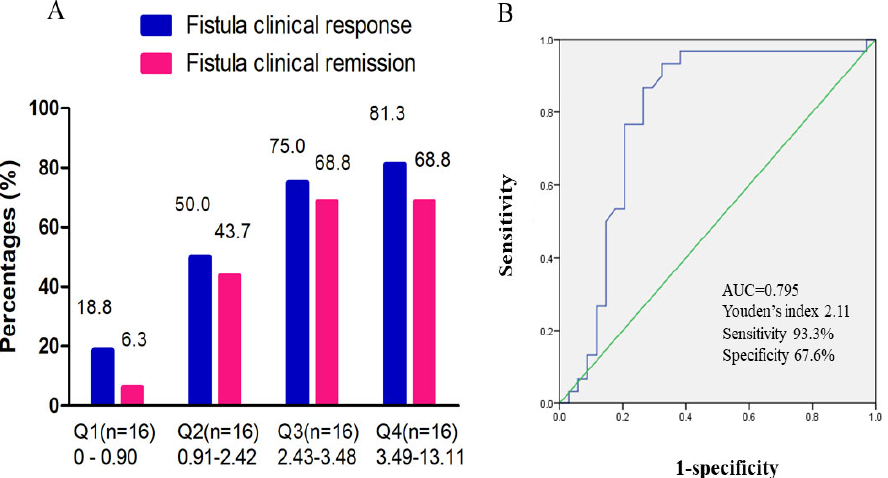
Figure 4. Exposure–response effect of UST on fistula clinical outcome. ( A ) Quartile analysis of UST trough concentration associated with fistula clinical remission and response. ( B ) ROC curve of UST trough concentration at week 16/20 predicting clinical fistula remission. The cut-off UST trough concentration was 2.11 µ g/mL, with an AUC of 0.795 [95%CI: 0.675–0.915], a sensitivity of 93.3%, and a specificity of 67.6%. ROC, receiver operating characteristic; UST, ustekinumab; AUC, area under the curve; CI, confidence interval.